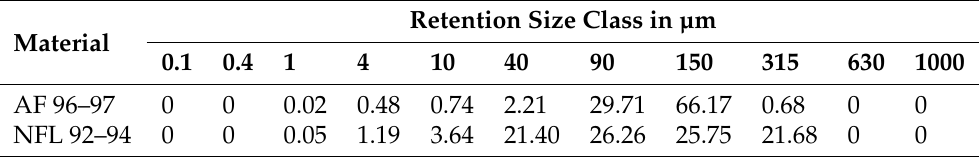
Table 1. Particle size retention distributions in wt% of the graphites determined by laser